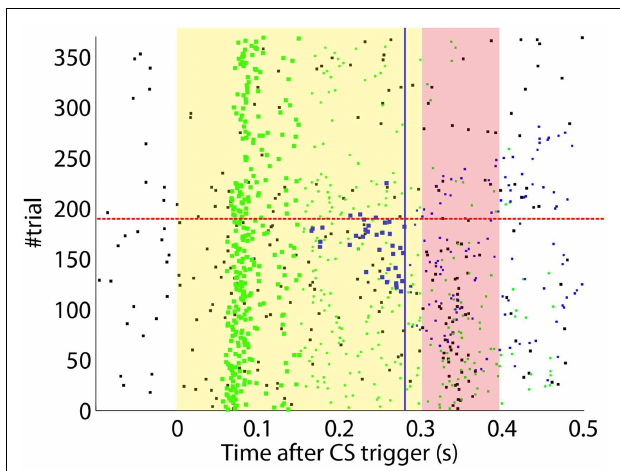
experiment. Raster plot with the PN detections (blue dots; well-timed PNs are thicker), IO detections (black), and CR triggers (blue dots; well-timed triggers are thicker).The CS (yellow area) and US (pink area) periods are indicated. Blue line separates well-timed from late CRs.The horizontal dashed red line separates acquisition and extinction